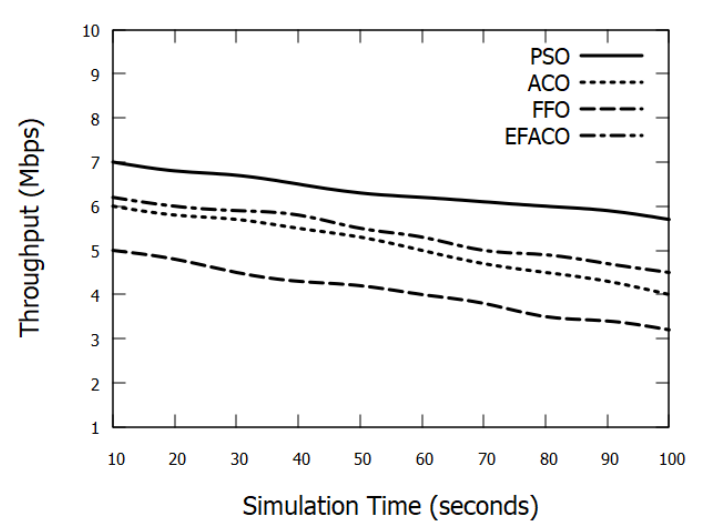
Figure 4. Comparison between proposed PSO, ACO, FFO, EFACO for throughput with simula- tion time.